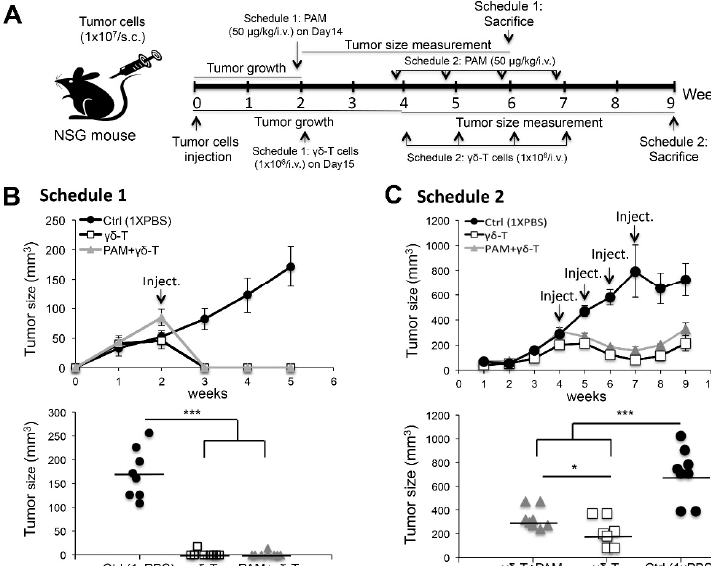
Figure 5. Adoptive transfer of ex vivo activated human V γ 9V δ 2 T-cells together with or without systemic pamidronate (PAM) treatment both showed effective eliminated the growth of subcutaneous (s.c.) human OVCAR3 cell xenografts in NSG mice. ( A ) Two detailed treatment schedules of in vivo study were shown in A. ( B ) In mice treated with schedule 1, the mean tumor size (mm 3 ) of eight mice ( n = 8 per group) during the treatment and follow-up period (upper panel). Tumor size (mm 3 ) measured at week six in individual mice in each group ( n = 8 per group; *** p < 0.001; lower panel). ( C ) In mice treated with schedule 2, mean tumor size (mm 3 ) of eight mice per group ( n = 8) were followed during experimental period (upper panel). Tumor size (mm 3 ) measured at week 9 in individual mice in each group ( n = 8 per group; * p < 0.05, *** p < 0.001; lower panel). Bars represent mean values. Int. J. Mol. Sci. 2019 , 20 , x FOR PEER REVIEW